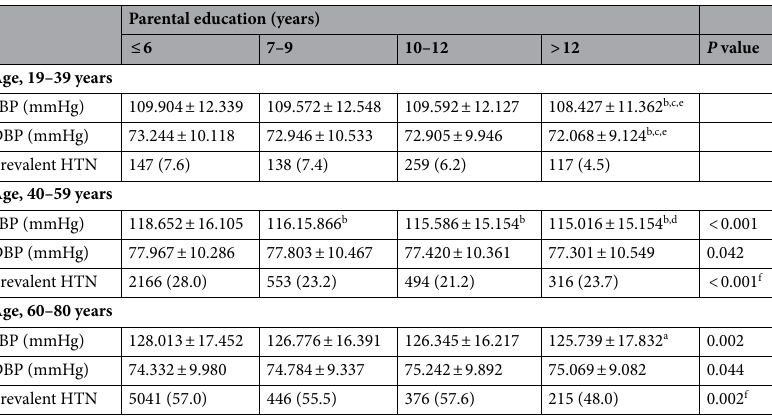
Table 3. Comparison of SBP, DBP, and prevalent HTN according to parental educational status in subgroups stratified by age. Values for categorical variables are given as number (percentage); values for continuous variables, as mean ± standard deviation. a P < 0.05, b P < 0.001 vs. subjects with parental education year ≤ 6; c P < 0.05; d P < 0.01 vs. subjects with parental education year 7–9; e P < 0.01 vs. subjects with parental education